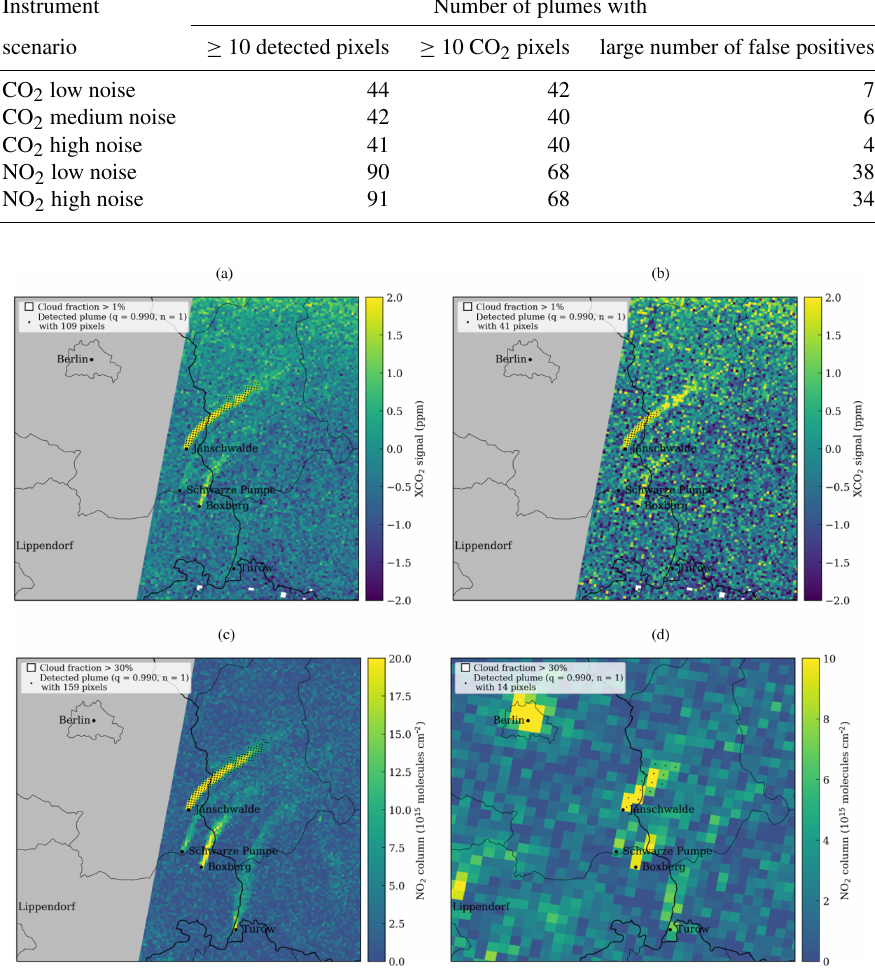
Figure 12. Example of plume detection for the Jänschwalde power plant on 2 November 2015 using (a, b) the CO 2 instrument with σ VEG50 of 0.5 and 1.0ppm, (c) the NO 2 instrument with the high-noise scenario and (d) the NO 2 instrument on